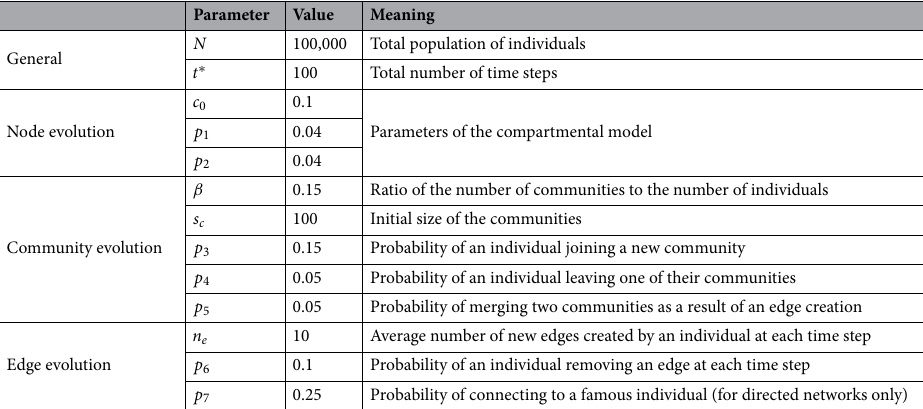
Table 1. Tunable parameters used in EpiCNet and a set of initial values for